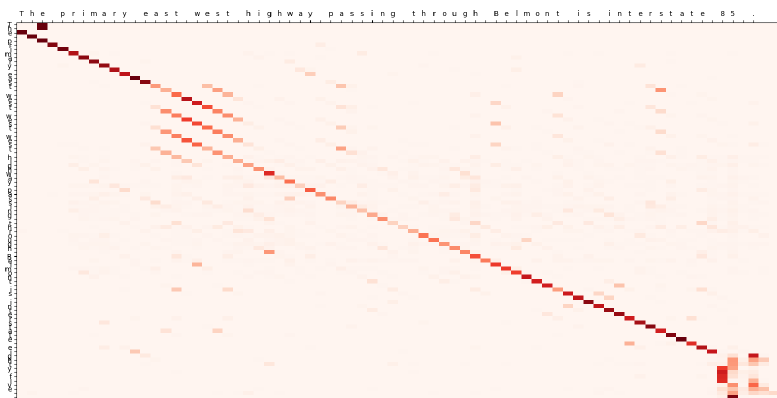
Figure 14. Attention matrix for a backwards finite jump error. The input sentence (horizontal axis) is “ The primary east west highway passing through Belmont is interstate 85. ” and the predicted output (vertical axis) is “ The primary east west west west highway passing through Belmont is interstate eighty five.